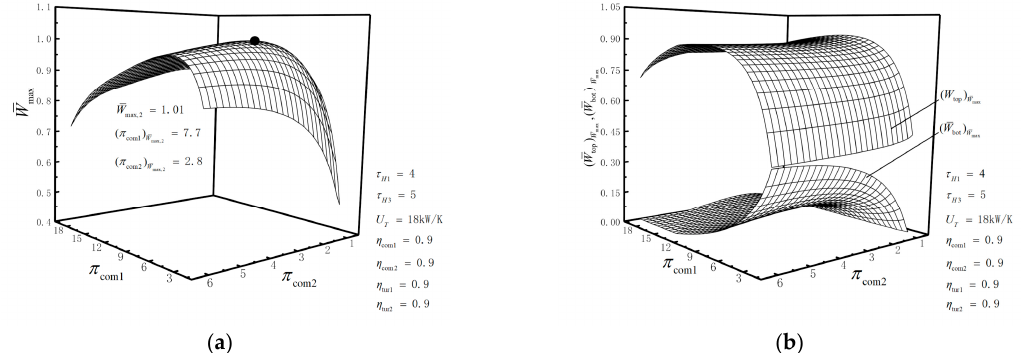
Figure 3. ( a ) Relationships of W max versus π com1 and π com2 ; ( b ) relationships of ( W top ) ( W ) versus π com1 and π com2 . bot W max